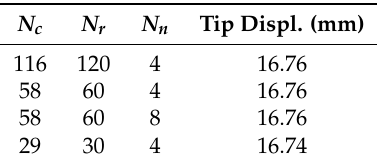
Table 4. Results of finite element method mesh convergence